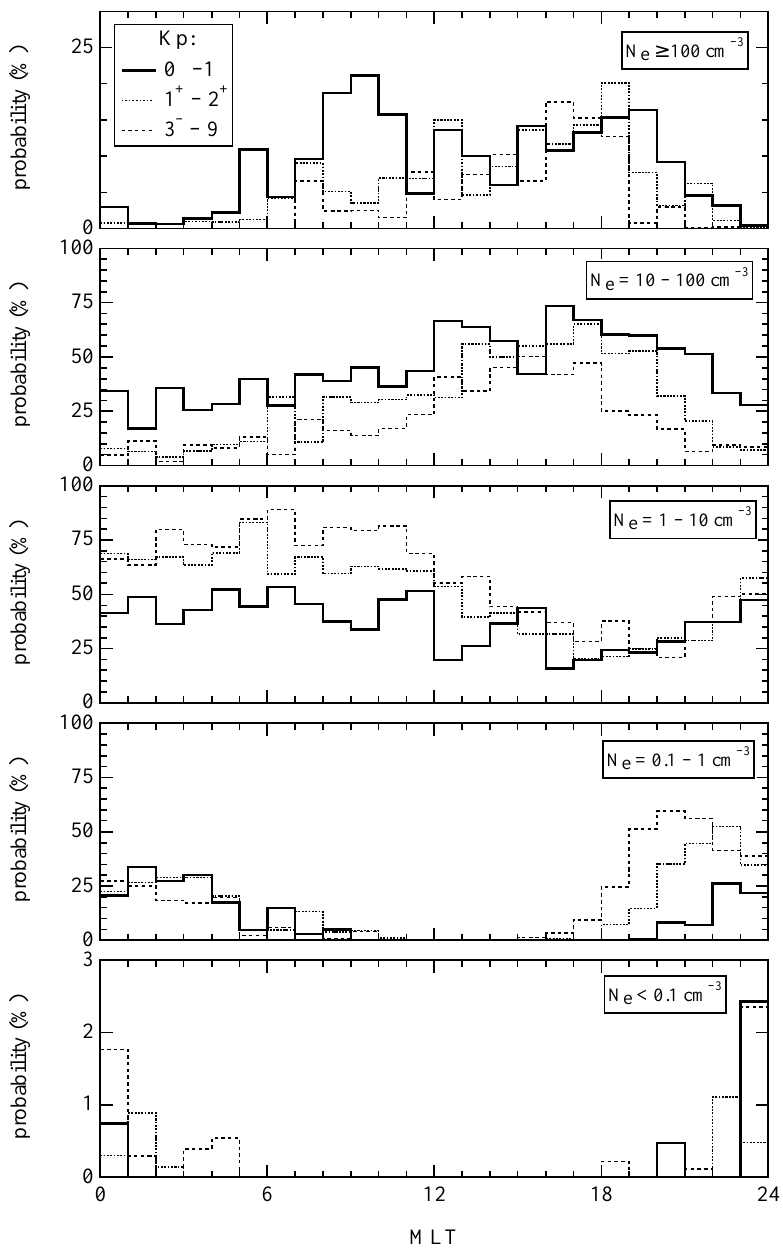
Fig. 8. Probabilities of detecting different density regimes at the geosynchronous distance as function of MLT. Three K p ranges are used: quiet periods (solid lines), weak disturbances (dotted lines), and strong disturbances (dashed lines). This figure uses data of Fig. 4.